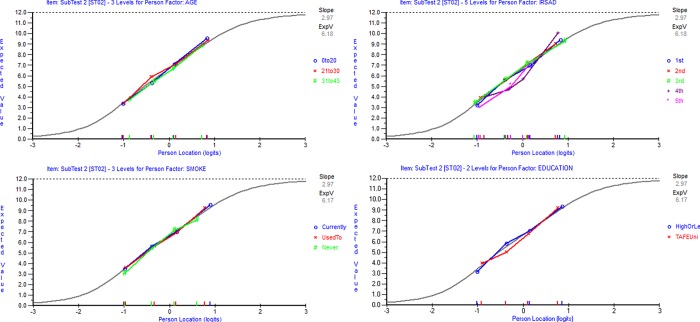
Analysis of Composite Item 2 DIF by Age (upper-left), Socioeconomic position (upper-right), Smoking status (bottom-left) and Education (bottom-right). Note. The colored points indicate the average observed item scores of each subgroup defined by an exogenous variable (e.g. the blue points in the bottom-left graph represent the average item scores of participants who currently smoked, the red points represent the average item scores of participants who used to smoke, and the green points represent the average item scores of participants who never smoked). The grey logistic curve indicates the expected item responses. The slope of the Item Characteristic Curve indicates the rate of change of the expected value with respect to the latent trait at the mid-point between the minimum and maximum scores.